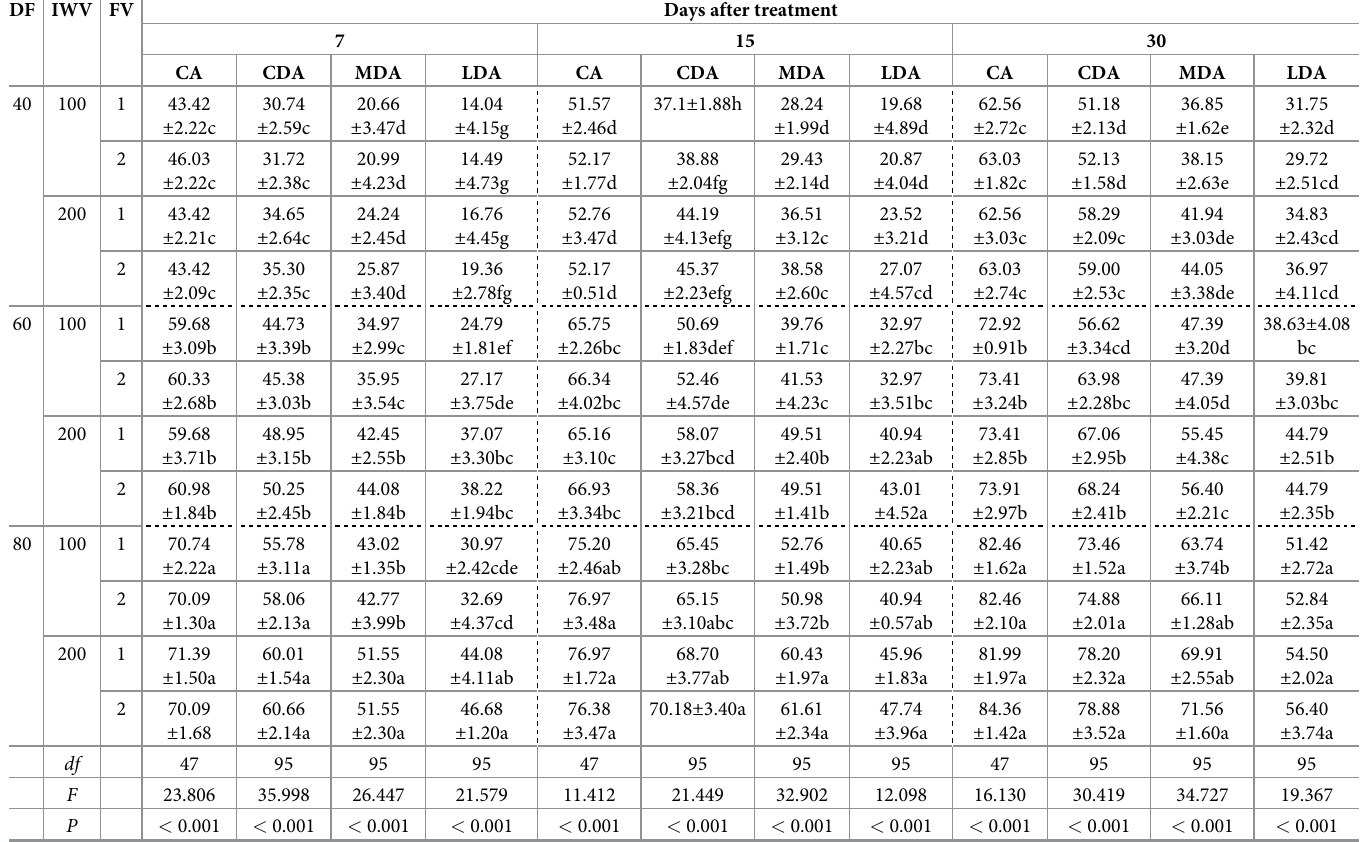
Table 1. Corrected mortalities from fluopyram applied by chemigation to control RKN in the field. DF IWV